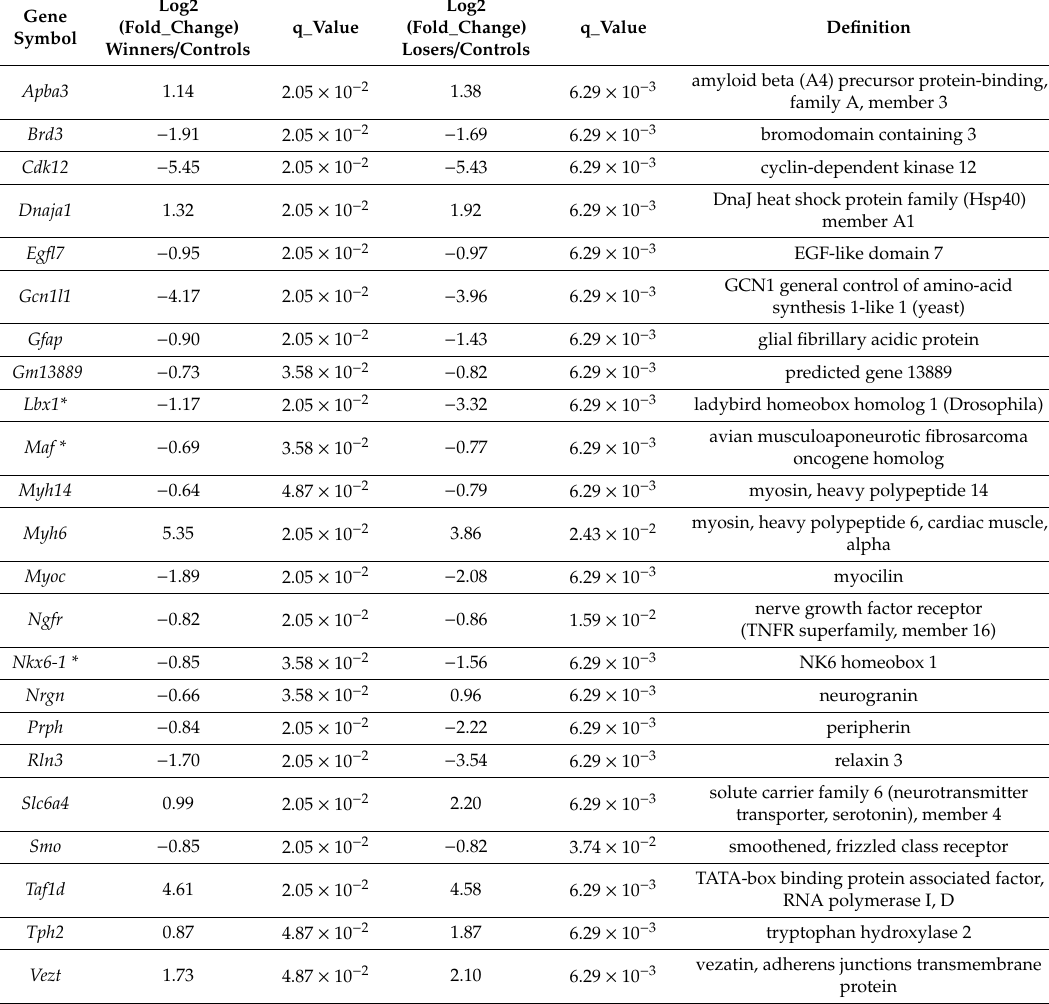
Table 4. DEGs with changed expression both for the winners and losers (common